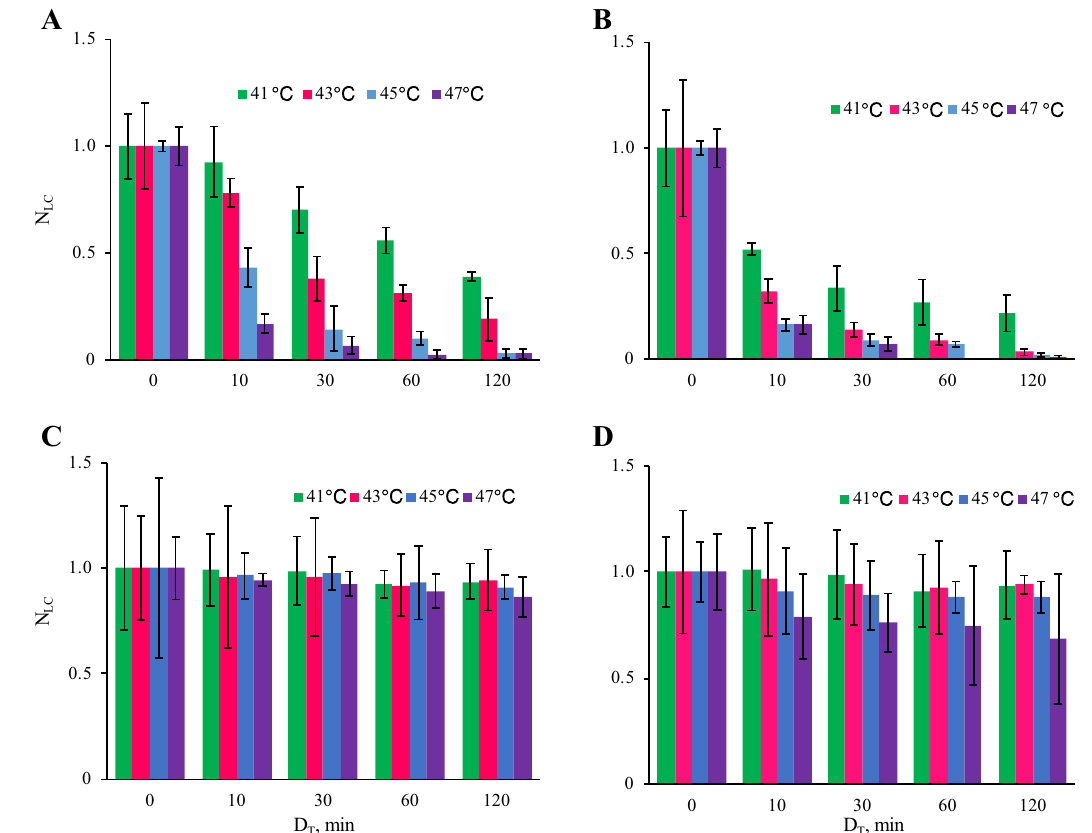
Figure 4. The number of live cells under each condition employed in our experiment. The viability of cancer cells decreased with increasing temperature and stimulus duration. The results of MCF-7 cells with culture for 30 min ( A ) and 24 h ( B ) after thermal stimulation and the results of NHDFs with culture for 30 min ( C ) and 24 h ( D ) after thermal stimulation ( n = 4, mean ± SD). N LC : The live cell number normalized to the live cell number without thermal stimulation. D T : Duration of the thermal stimulation. The statistical analysis was performed with every temperature condition and the results are shown in Fig. S4. Note that no statistically significant difference was found in the results of